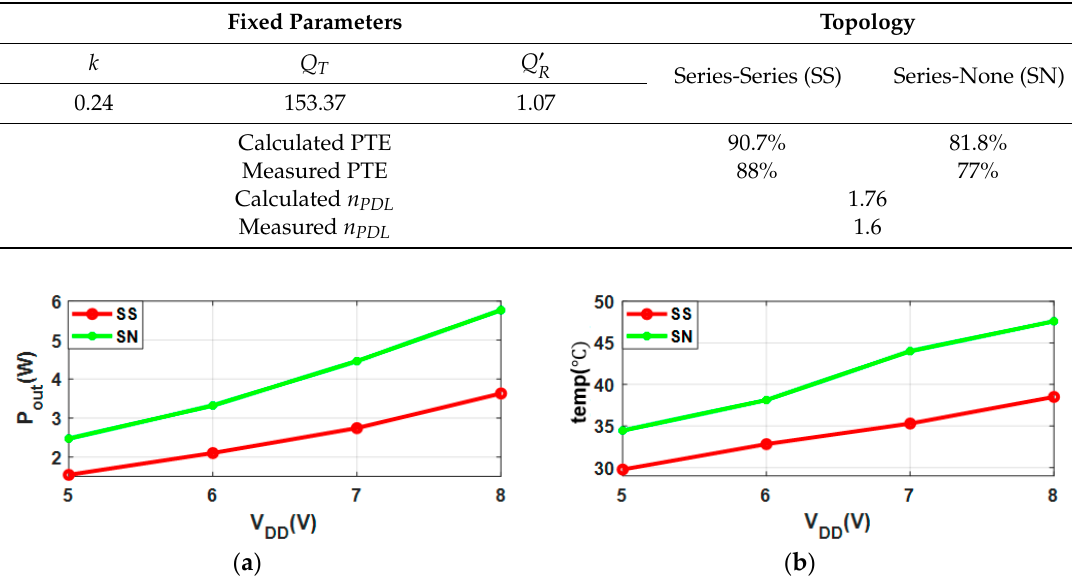
Figure 9. Measured ( a ) power delivered to load (PDL) and ( b ) temperature of wearable textile heater for SS and SN modes with respect to controllable PA supply voltage V DD .